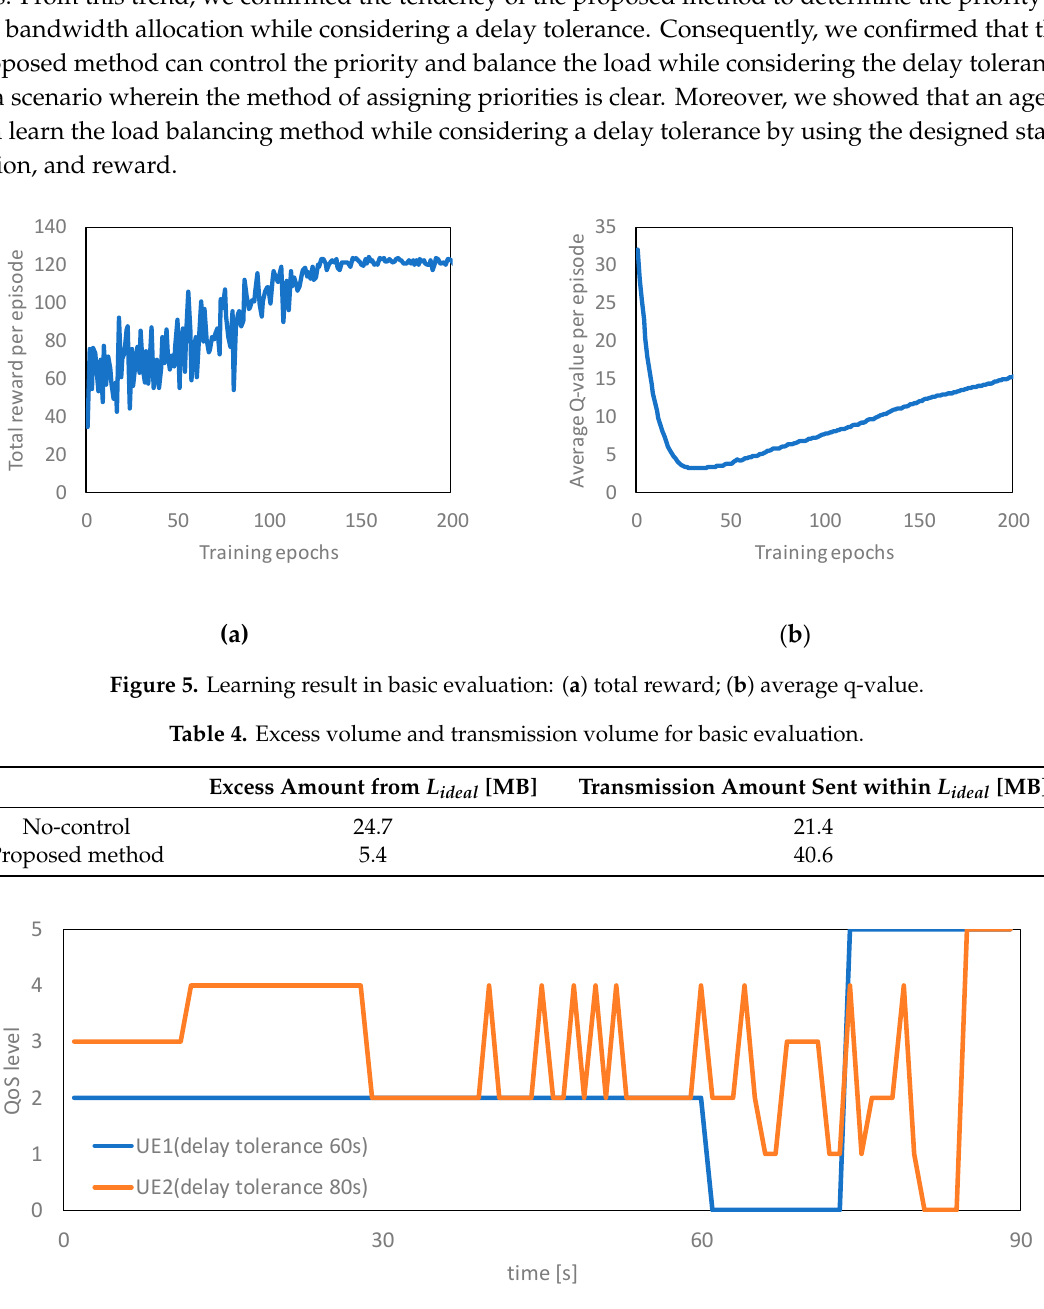
Figure 6. QoS level assignment.